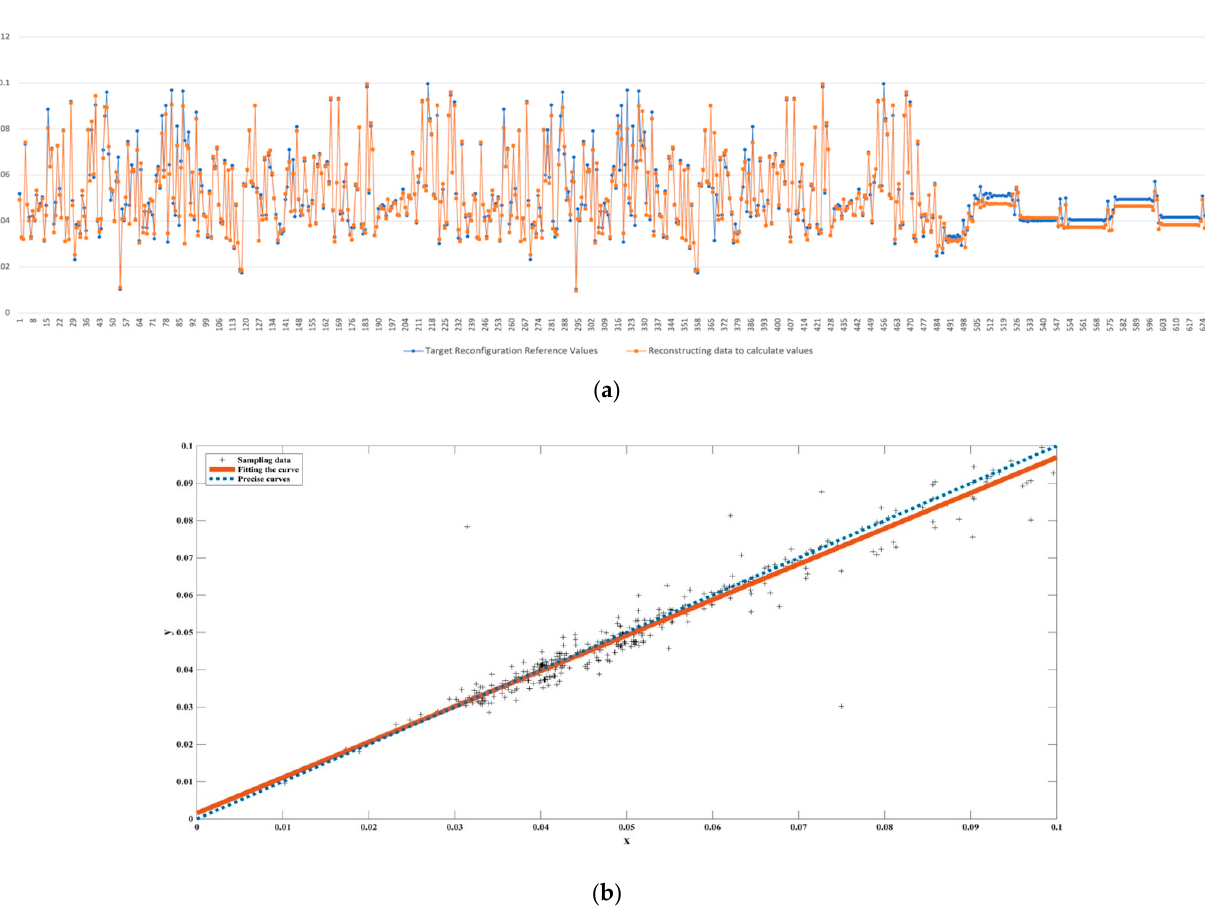
Figure 5. Global container shipping network reconfiguration results comparison (625 ports): ( a ) direct comparison; ( b ) fitted comparison.